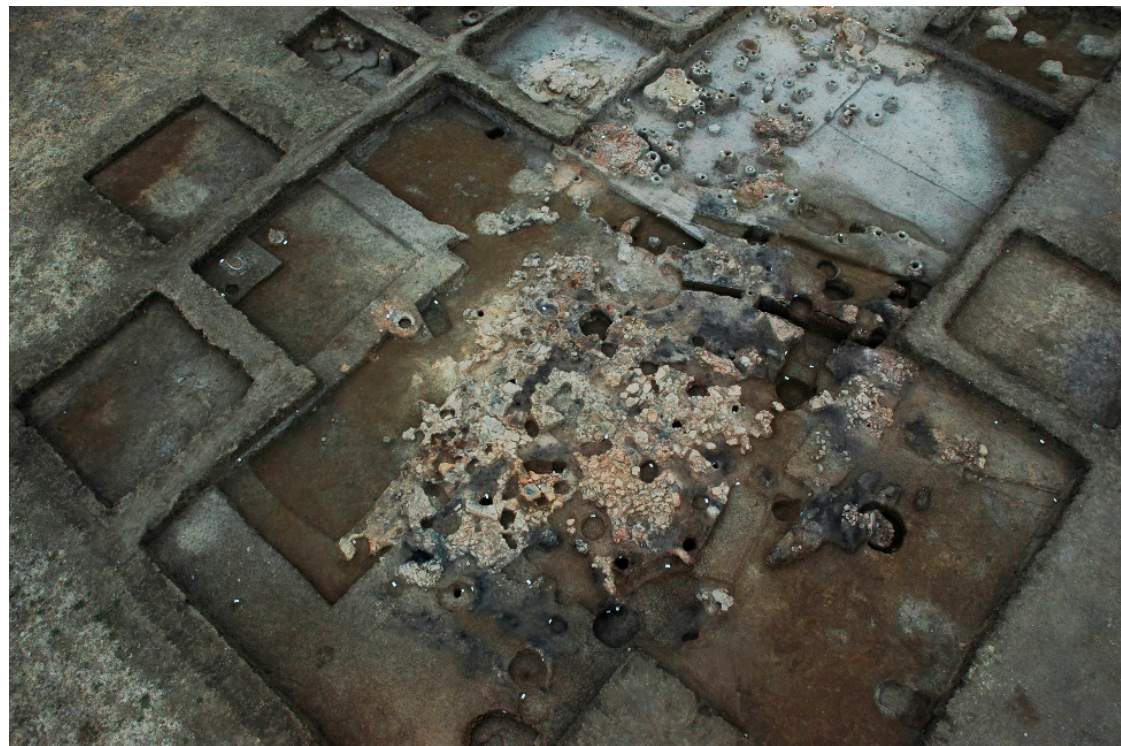
Figure 9. AVGI I: Building 5 and the neighboring open